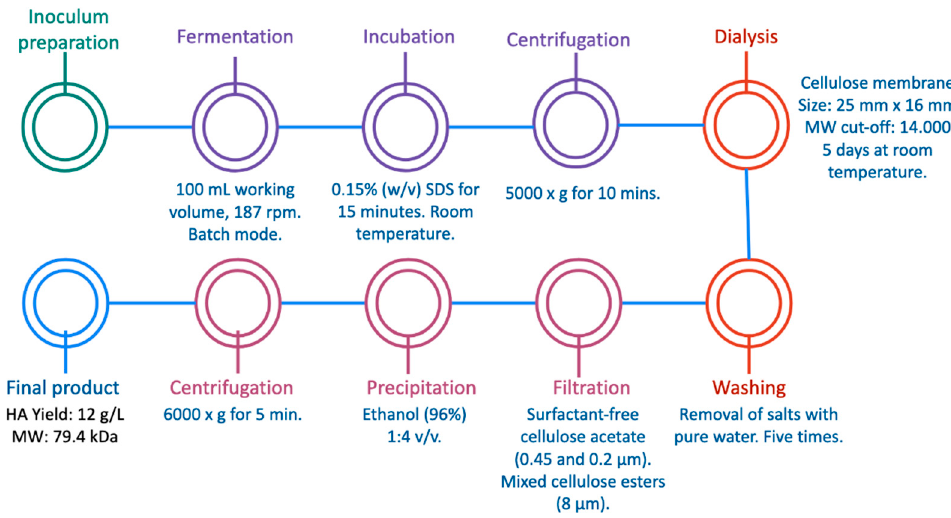
Figure 3. Hyaluronic acid production by Streptococcus equi ssp. equi by a sequential process [20].